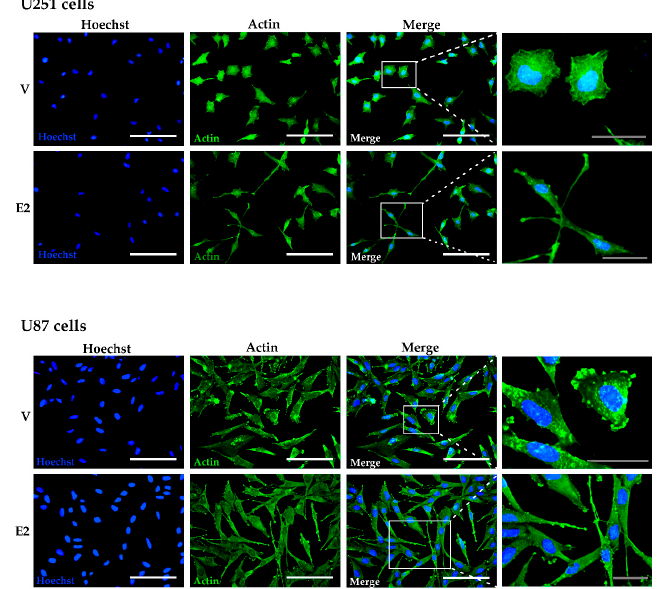
Figure 3. E2 rearranged the actin cytoskeleton of human GBM-derived cells. Actin immunostaining in U251 and U87 cells treated with 17 β -estradiol (E2, 10 nM) and vehicle (V, 0.01% cyclodextrin) for 48 h. Representative images captured under a fluorescence microscope at a magnification of 400×. Magnification white bar = 100 μ m and gray bar = 30 μ m.